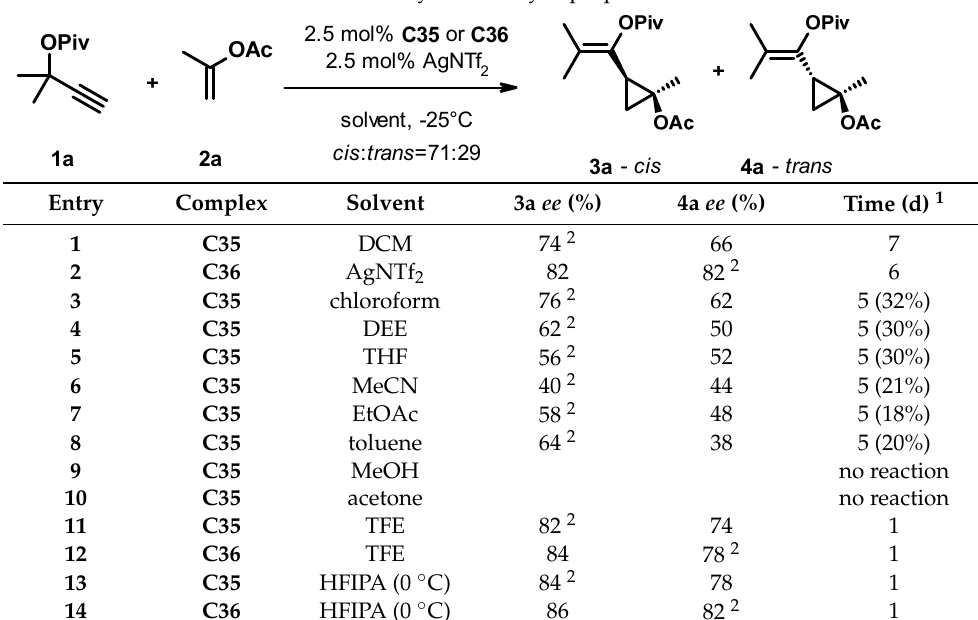
Table 3. The effect of the solvent on the asymmetric cyclopropanation.